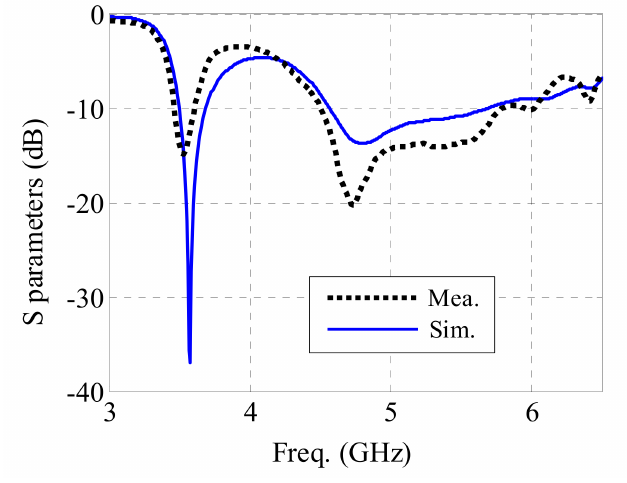
Figure 9. S parameter of the proposed antenna